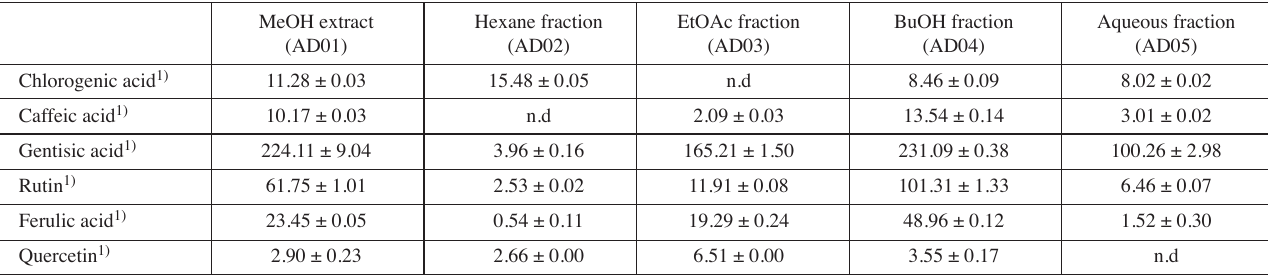
Tab. 1: Polyphenolic compounds in Abeliophyllum distichum methanol crude extract and its fractions.